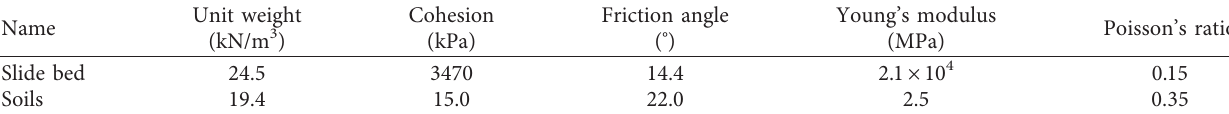
Table 1: Physical and mechanical parameters of the model test